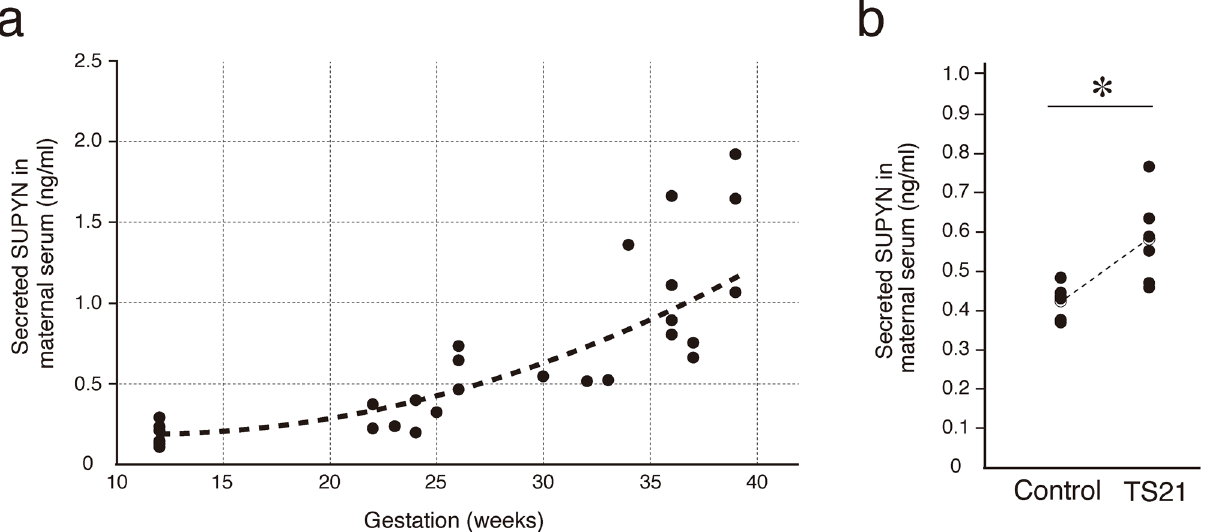
Figure 2. Quantification of secreted SUPYN protein in the TS21 maternal serum. ( a ) SUPYN-specific ELISA to monitor maternal SUPYN serum levels in normal pregnancies. ( b ) Quantification of secreted SUPYN protein (ng/ml) in serum from TS21 and gestational age-matched control pregnancies using a SUPYN-specific ELISA. Statistical analysis was performed using the Mann Whitney U test. Statistical significance was set at * : p < 0.05. Values represent mean ± SD (n >